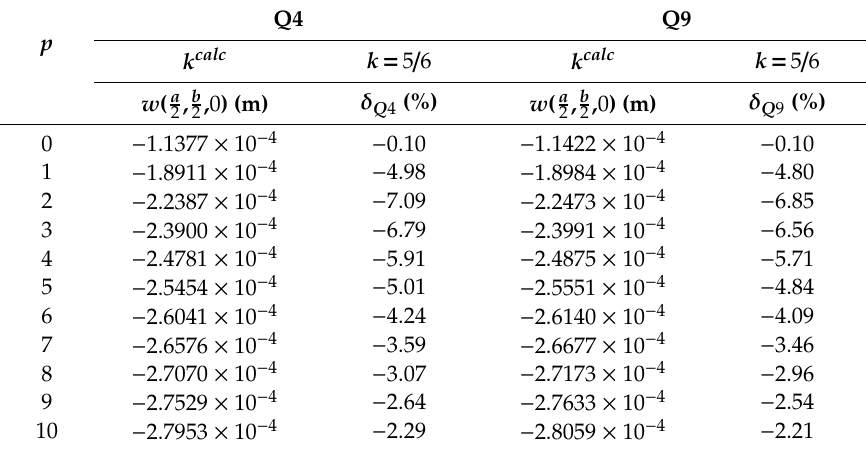
Table 9. Porosity distribution model M3: plate’s center transverse displacement for di ff erent finite elements and shear correction factor